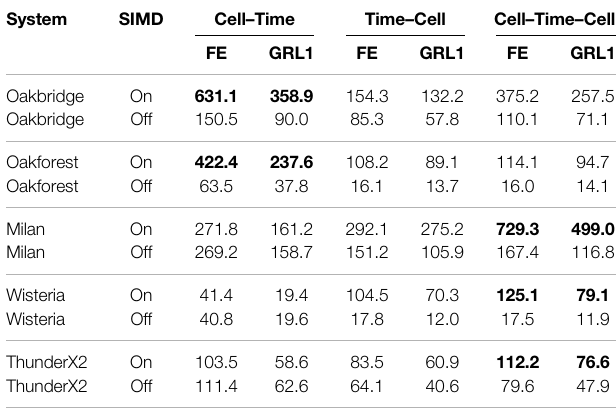
TABLE 6 | Single-threaded performance of naïve and auto-vectorised implementations.TheFEschemeisused; C =11688851cells. “ SoA ” refersto the “ struct of arrays ” memory layout discussed in Section 2.3.2